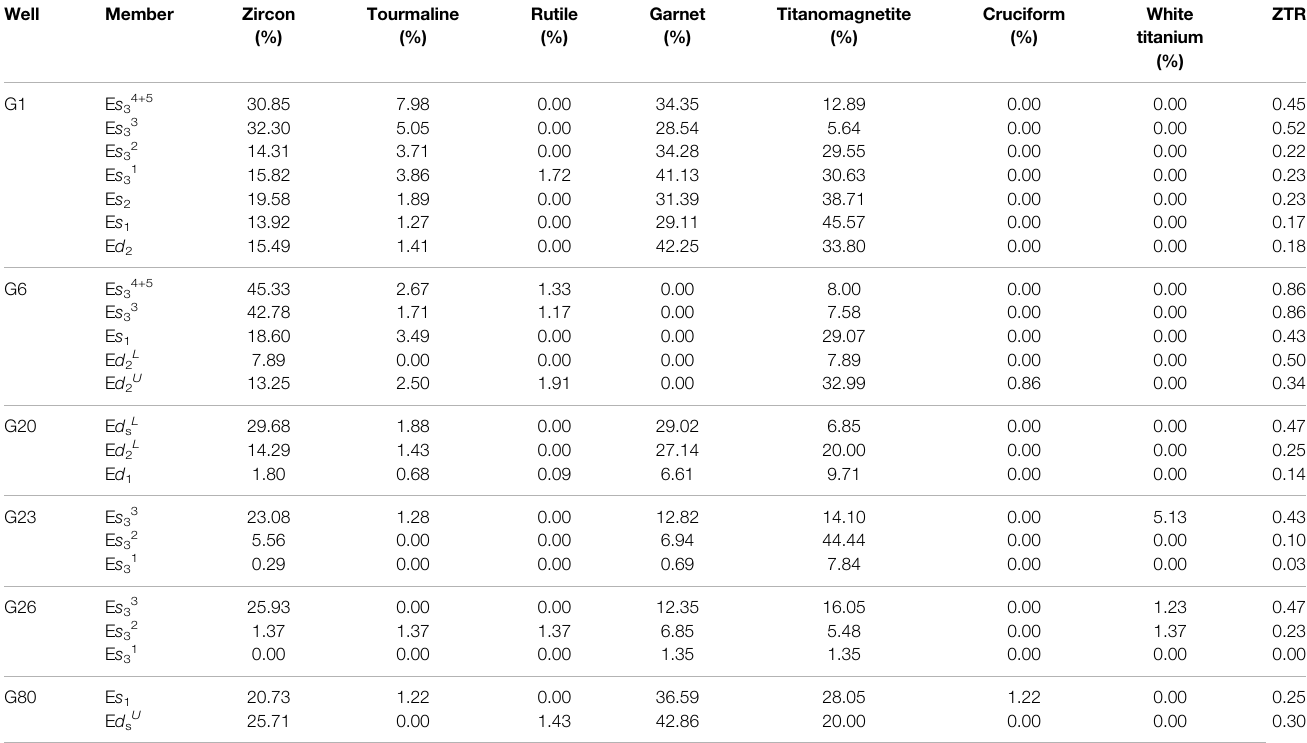
TABLE 1 | Heavy mineral assemblages of different periods in Nanpu